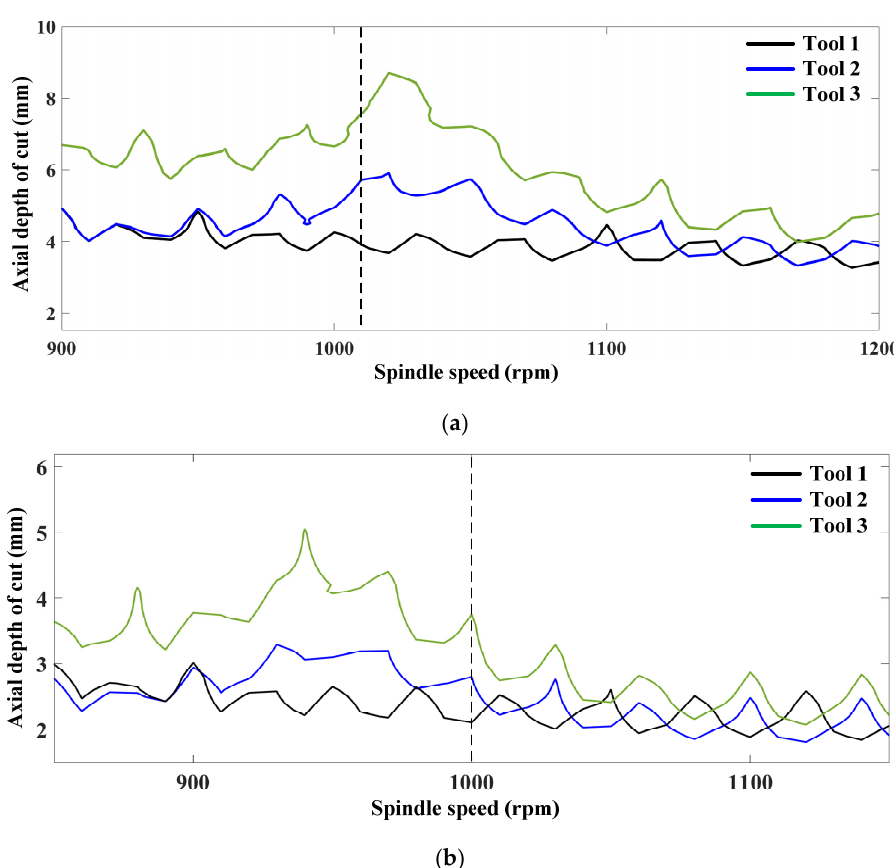
Figure 5. Stability lobe diagrams under different tool design; ( a ) industrial cases; ( b ) laboratory cases.